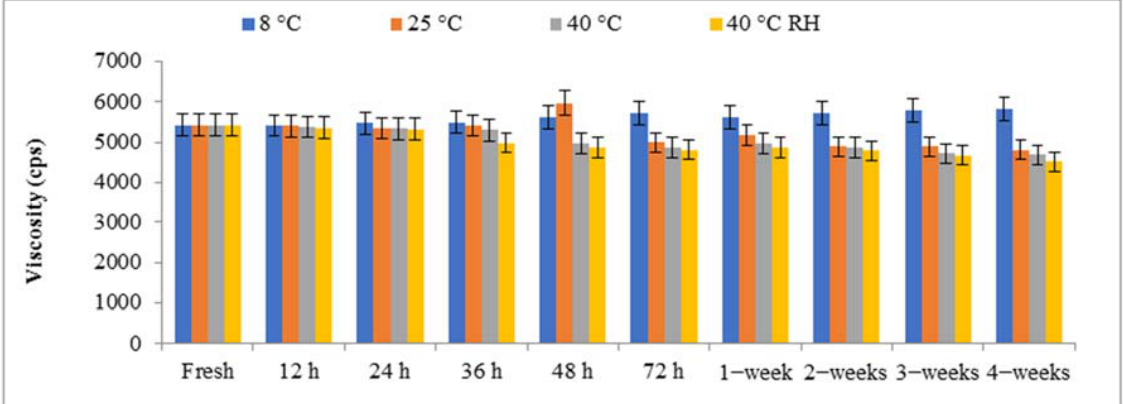
Figure 7. Viscosity of SNP nanoparticles of Citrus limon extract embedded in nanohydrogel for- mulation (NHGF4) at various temperatures (8 °C, 25 °C, 40 °C, and 40 °C RH), respectively.